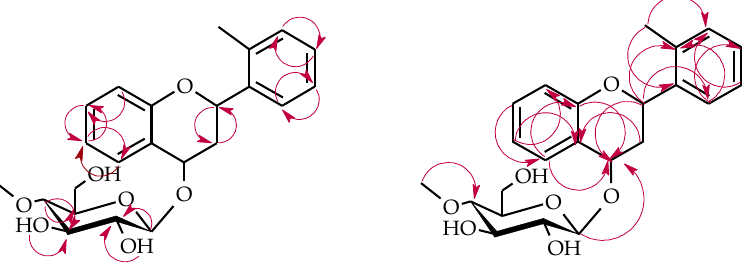
of product 4c . Table 1. 1 H- NMR chemical shifts δ (ppm) and coupling constants J (Hz) of 2′ -methylflavanone ( 4 ) and products of its biotransformations 4a – 4e in Acetone-d6, 600 MHz (Supplementary Materials: Figures S2, S18, S38, S54, S72, S90). Proton